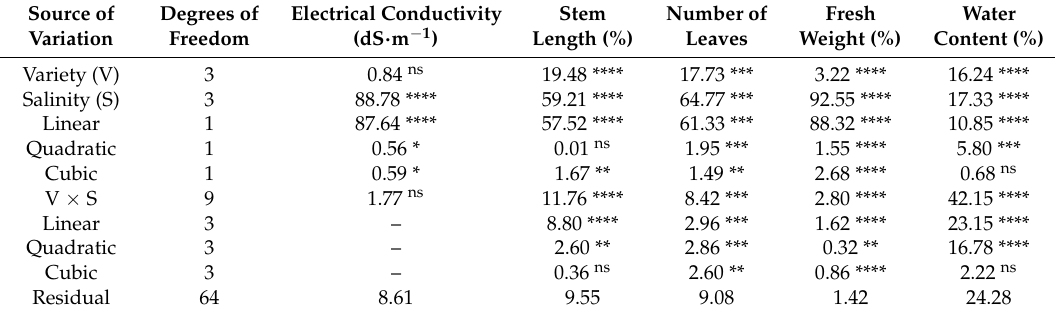
Table 2. Percentage of the total sum of squares for the effects of variety (V), salinity (S), and their interaction (V × S) for the substrate electrical conductivity and plant growth parameters of four Phaseolus varieties grown at four salinity levels (0, 50, 100, and 150 mM of added NaCl to the medium solution). For the S and V × S sources of variation, the sum of squares has been decomposed in the linear, quadratic, and cubic